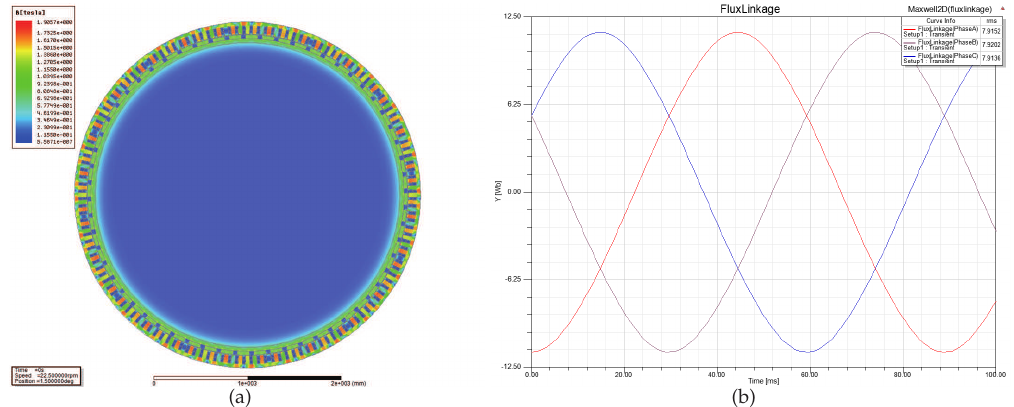
Figure 13. Results of finite element analysis with ψ f ≈ 7.92 Wb in Case 5 : ( a ) Nephogram of magnetic flux density; ( b ) Corresponding waveform of magnetic flux linkage.